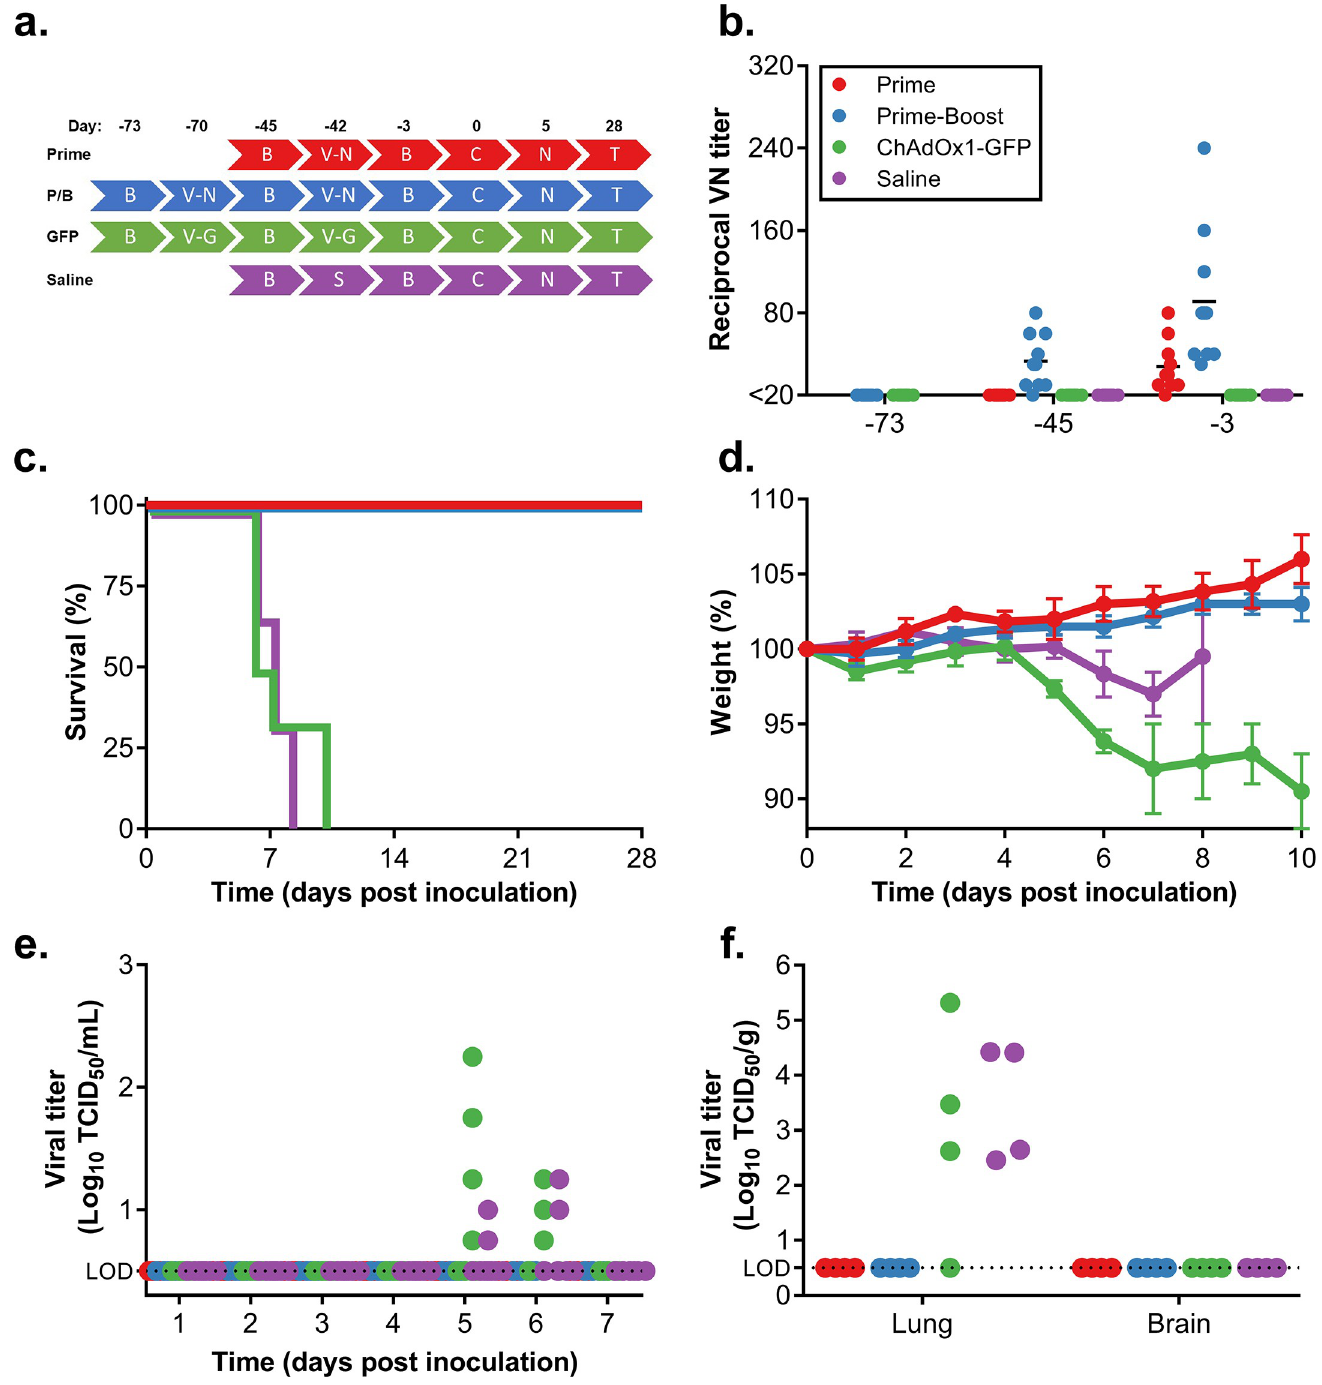
Fig 1. Single-dose vaccination with ChAdOx1 NiV B protects Syrian hamsters against a lethal challenge with NiV Bangladesh. (a) Experimental layout. P/ B = prime-boost; B = bleed; V-N = ChAdOx1 NiV B vaccination; V-G = ChAdOx1 GFP injection; S = saline injection; C = challenge; N = necropsy; T = Termination experiment. (b) Neutralizing antibodies in serum were determined via virus neutralization assay on VeroE6 cells at D-73, D-45 and D-3. (c) Survival of Syrian hamsters challenged with NiV Bangladesh. Survival of vaccinated animals was significant compared to control animals ( P = < 0.0001). (d) Weight loss of challenged animals. (e) Shedding of infectious virus in oropharyngeal swabs collected daily from challenged animals. NiV titers were determined via endpoint titration on VeroE6 cells. (f) Infectious virus titers in lung and brain tissue collected from challenged animals at D5. NiV titers were determined via endpoint titration on VeroE6